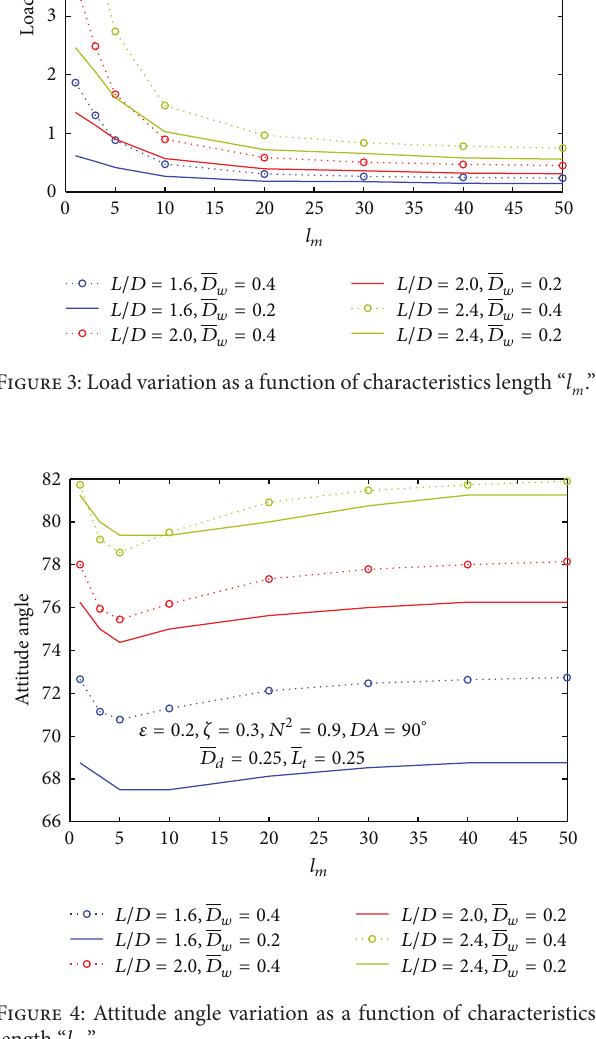
Figure 4: Attitude angle variation as a function of characteristics length “ l m